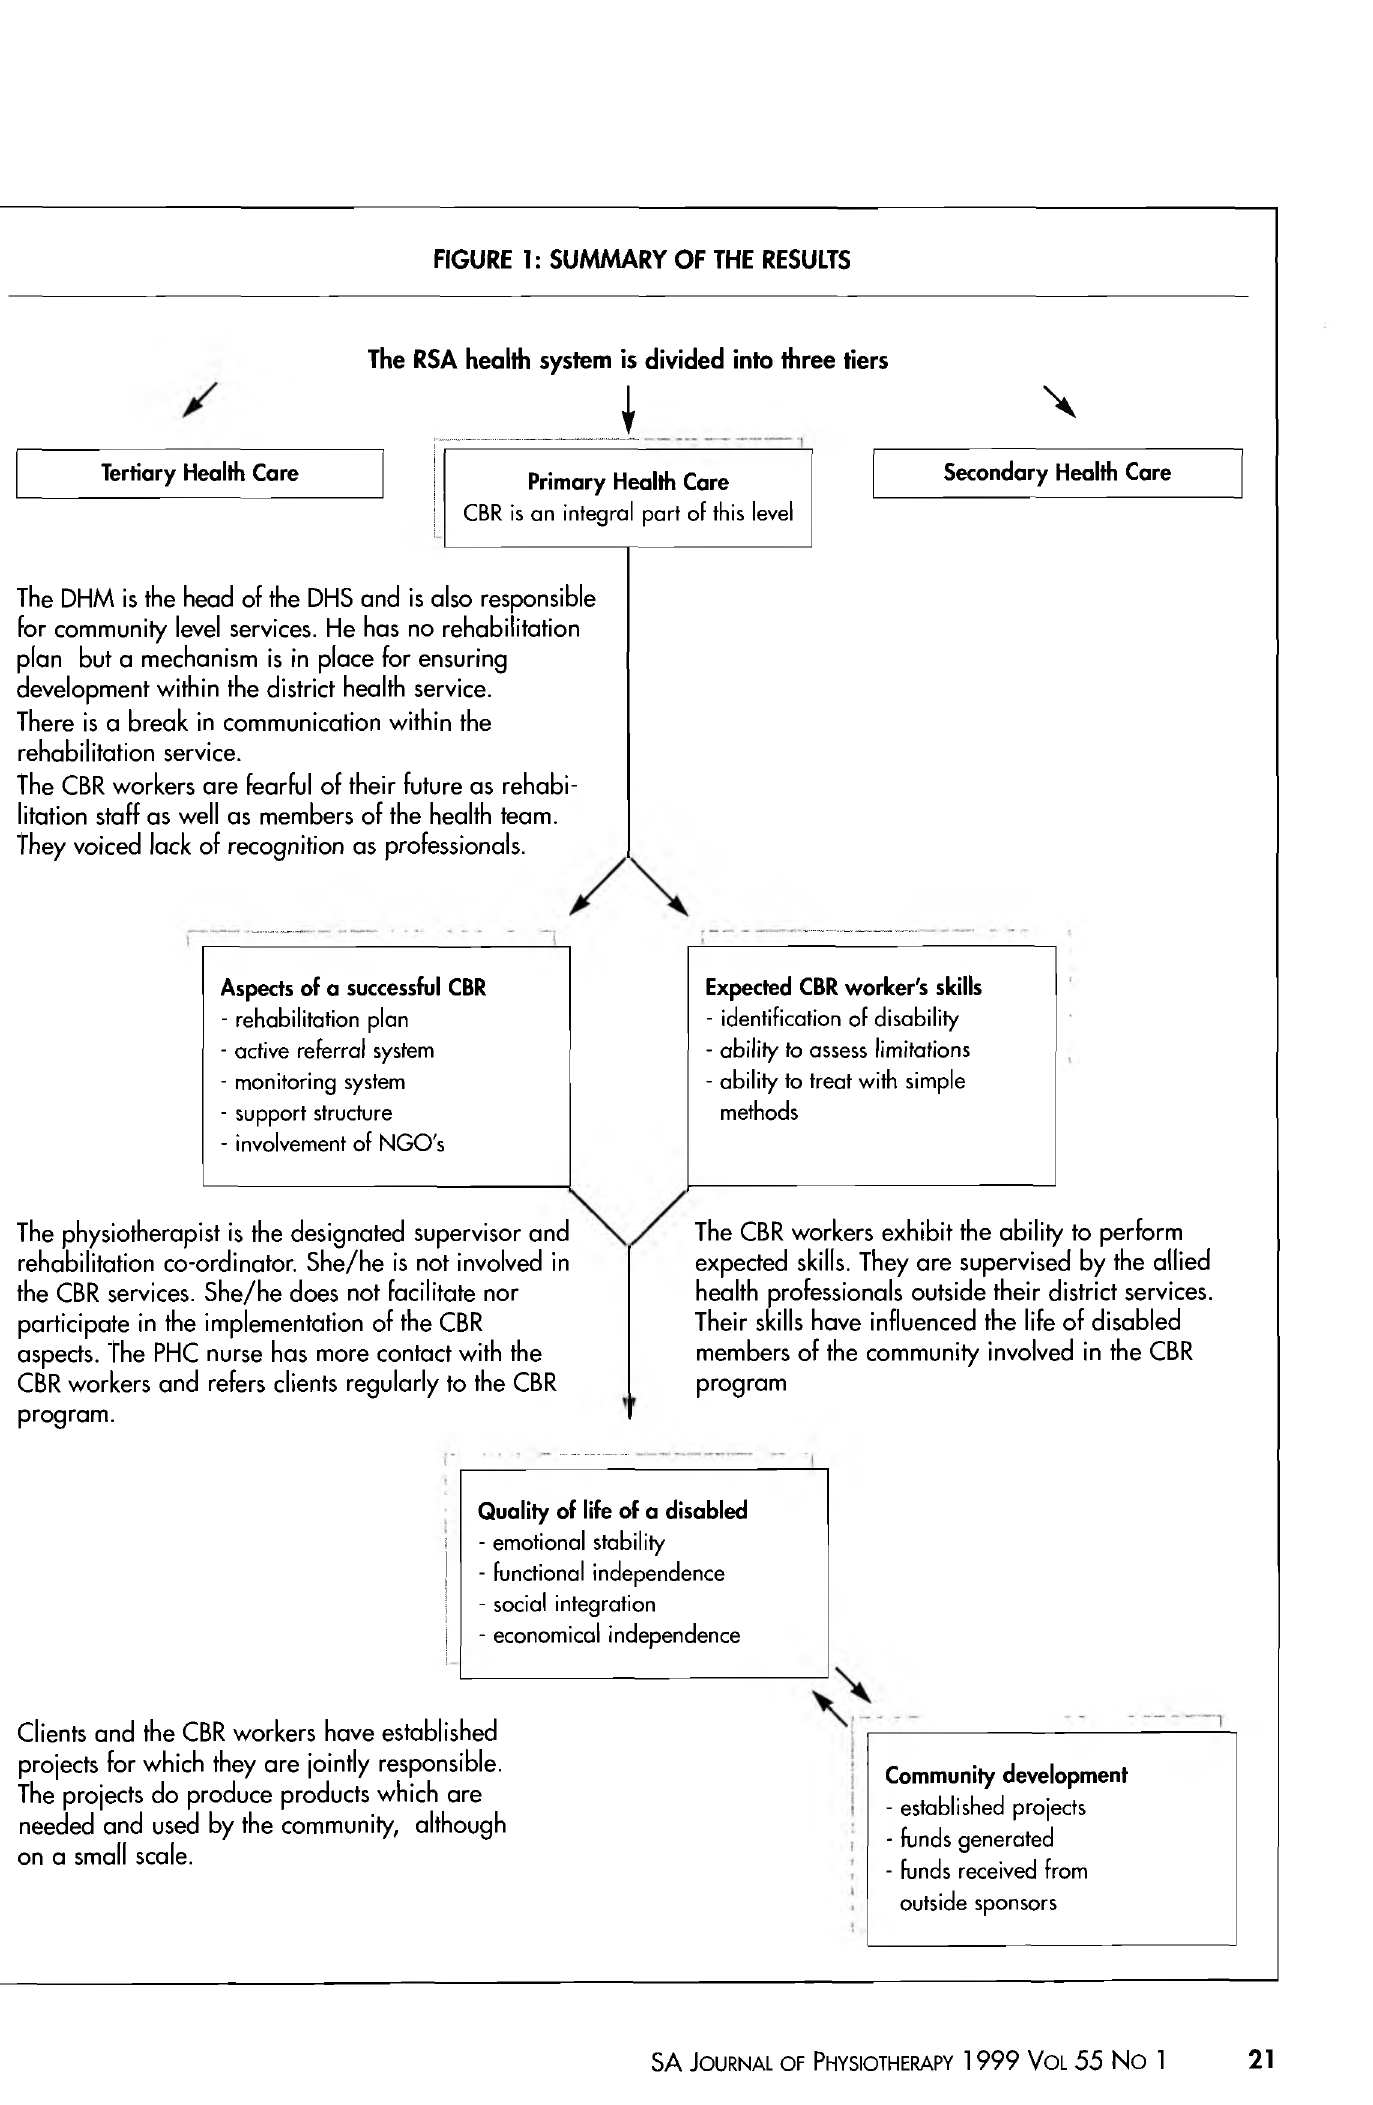
FIGURE I: SUMMARY OF THE RESULTS